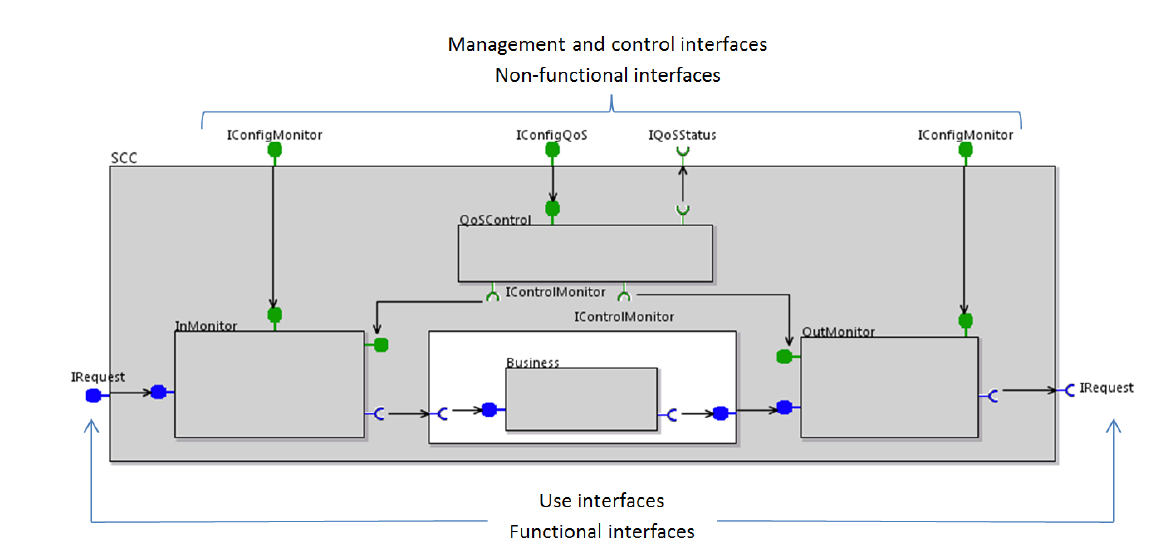
Figure 1. Self-Controlled service Component